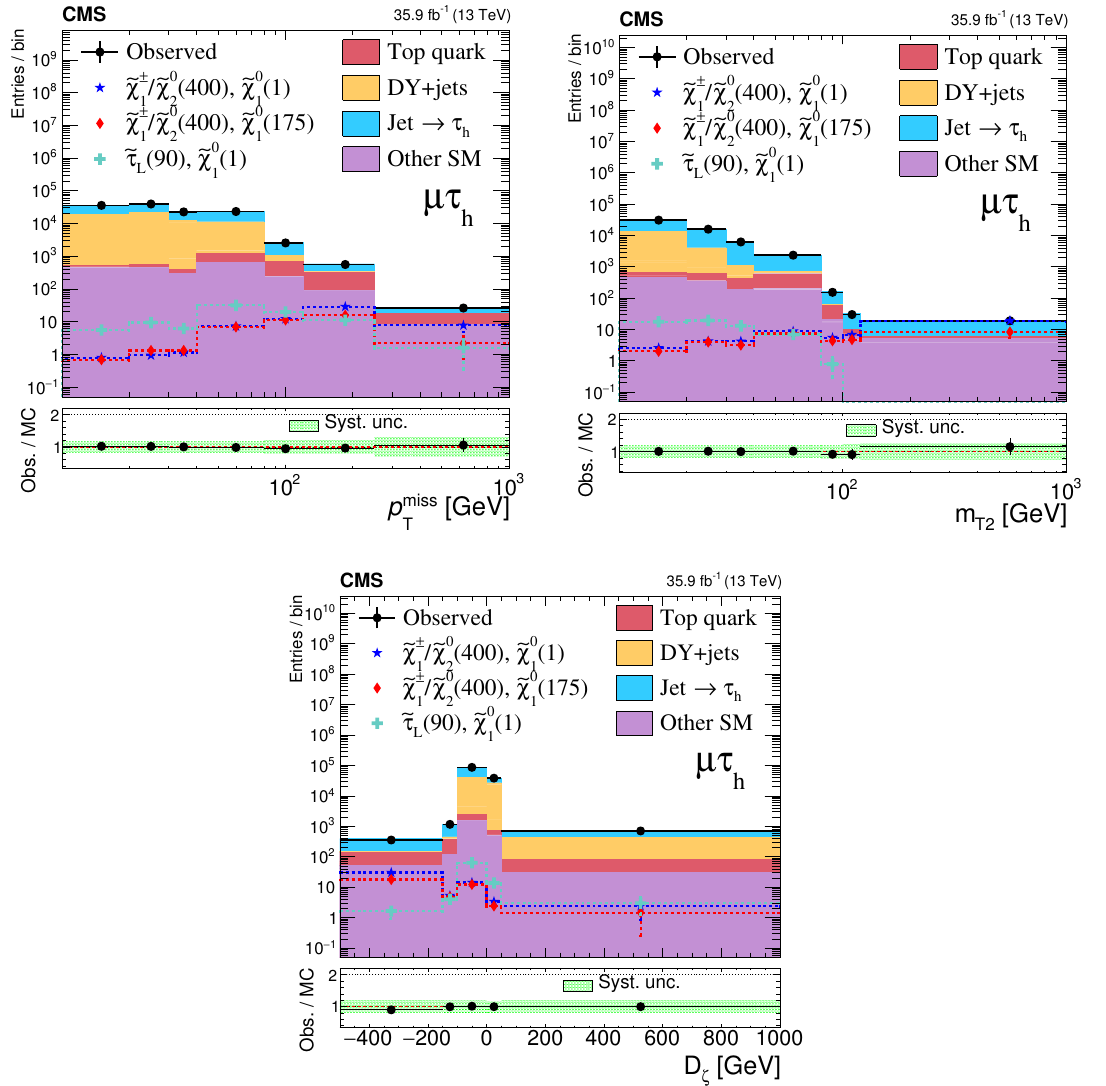
Figure 6. Distributions of the search variables p miss (top left), m T2 (top right), and D (cid:16) (bottom) T for the (cid:22)(cid:28) h (cid:12)nal state for events after the baseline selection. The black points show the data. The background estimates are represented with stacked histograms. Distributions for two benchmark models of chargino-neutralino production, and one of direct left-handed (cid:28) pair production, are overlaid. The numbers within parentheses in the legend correspond to the masses of the parent SUSY particle and the (cid:31) 0 in GeV for these benchmark models. In all cases, the last bin includes e 1 e